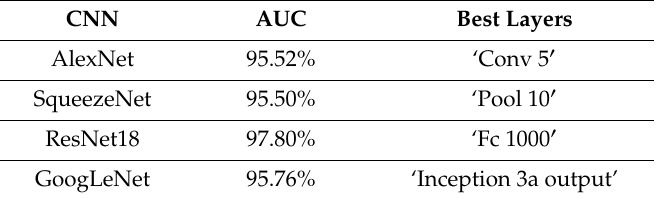
Table 7. Best AUC results obtained by CNN used as feature extractors. AUC